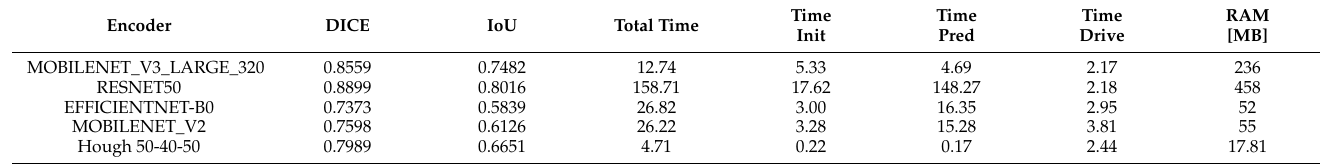
Table 8. Results of algorithms running on the educational robot Fischertechnik with Raspberry Pi. Time init represents the average network initialization time, and Time pred is the average time of image prediction. Total time is the sum of times for initialization, prediction, getting images from camera, transformation, targeting and driving forward and saving images. All times are in seconds. DICE and IoU were calculated as a result of three different room light conditions: one bulb, three bulbs and an LED smartphone flashlight including the six positions of the